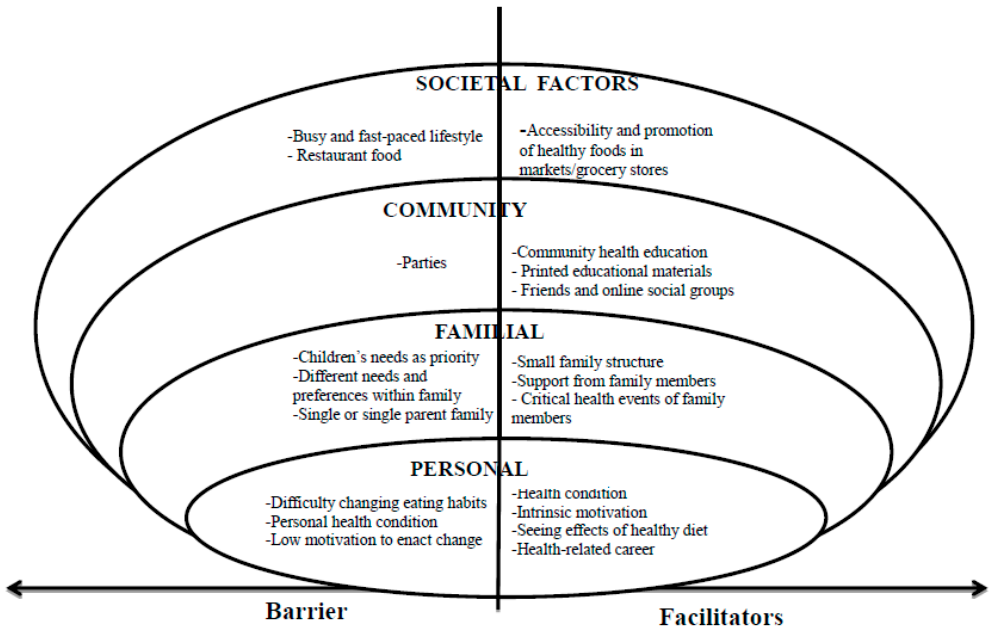
Figure 1. Facilitators of and Barriers to Healthy Eating.